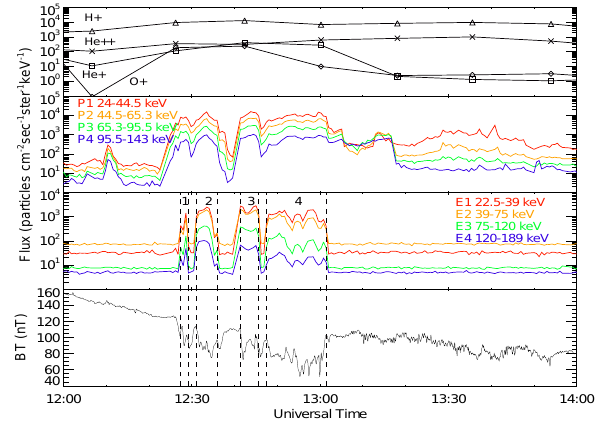
Fig. 2. ISEE-1 Plasma Experiment data (40eV–17.36keV), where triangles, X’s, open squares, and diamonds correspond to H + , He ++ , He + , and O + ions respectively (top or first panel). The time resolution for the plasma data is 18 minutes. The second and third panels contain the proton and electron fluxes respectively, in- tegrated over all PA for four energy channels measured by ISEE-1. The proton and electron flux are presented with a time resolution of 36s. Panel four shows the total local magnetic field strength. The local magnetic field strength is displayed with 4 second resolution. The four zones of increased flux are marked with vertical dotted lines and labeled sequentially in panels three and